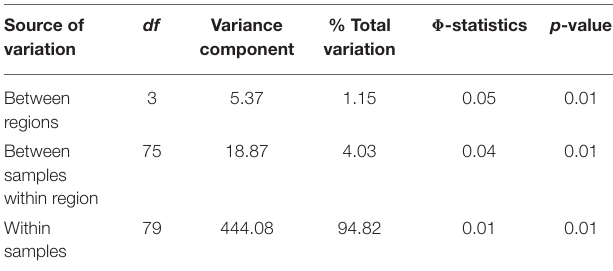
TABLE 2 | Analysis of molecular variance (AMOVA) of the Tetramorium immigrans SNPs data using clustering between the four geographical regions. Source of